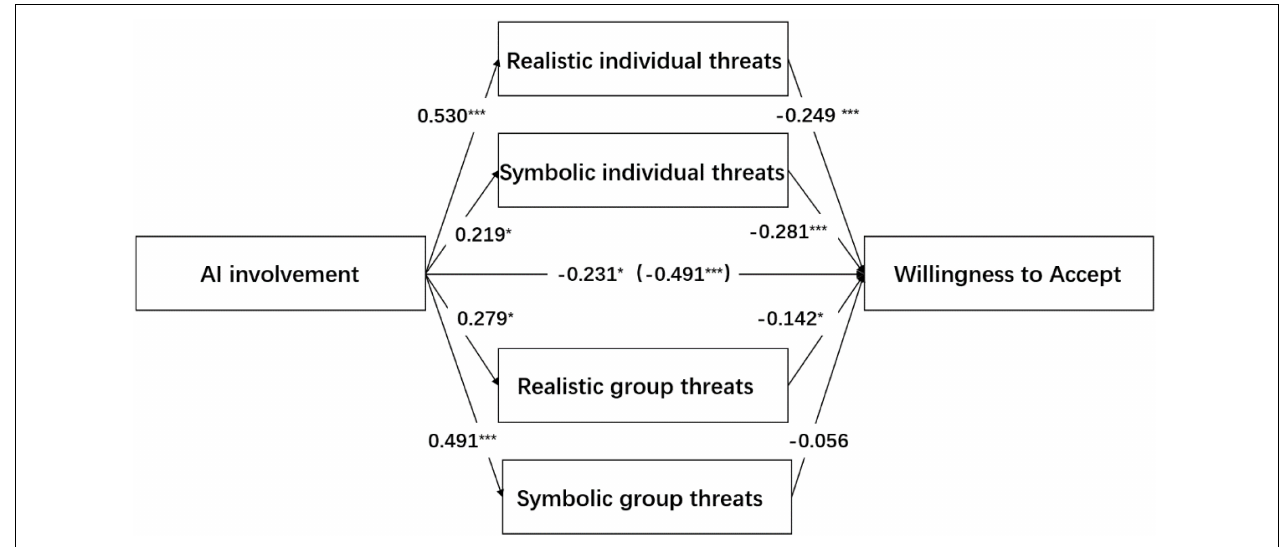
FIGURE 3 | The result of experiment 2. * p < 0.05, *** p <